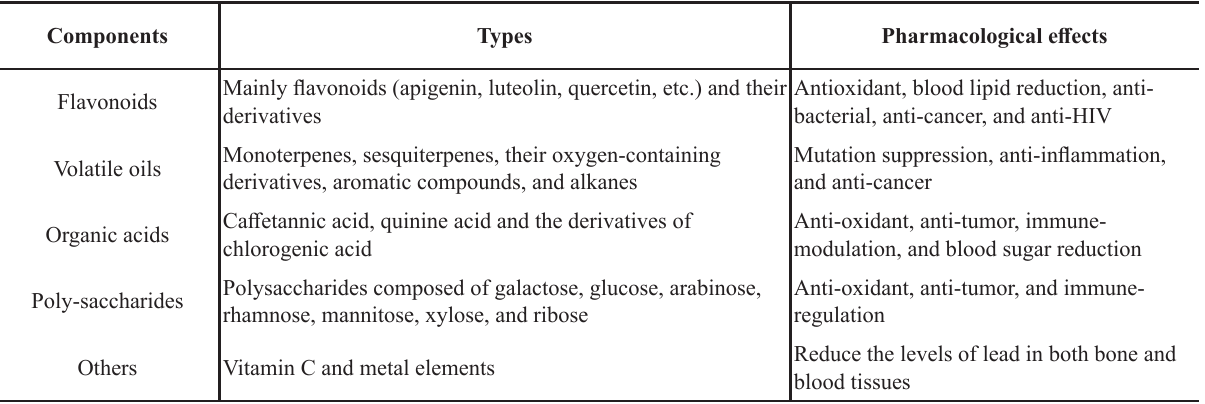
Table 1. General categories of the currently reported main components from chrysanthemum and their potential pharmacological Components